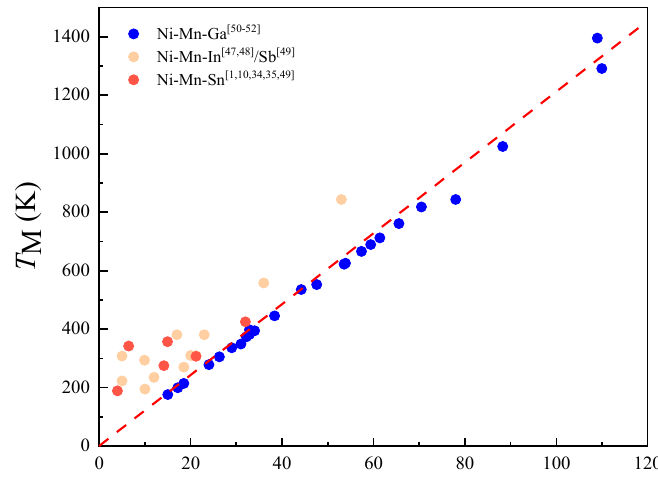
Figure 5. Relationship of ΔΕ A-M and experimental T M of alloys.